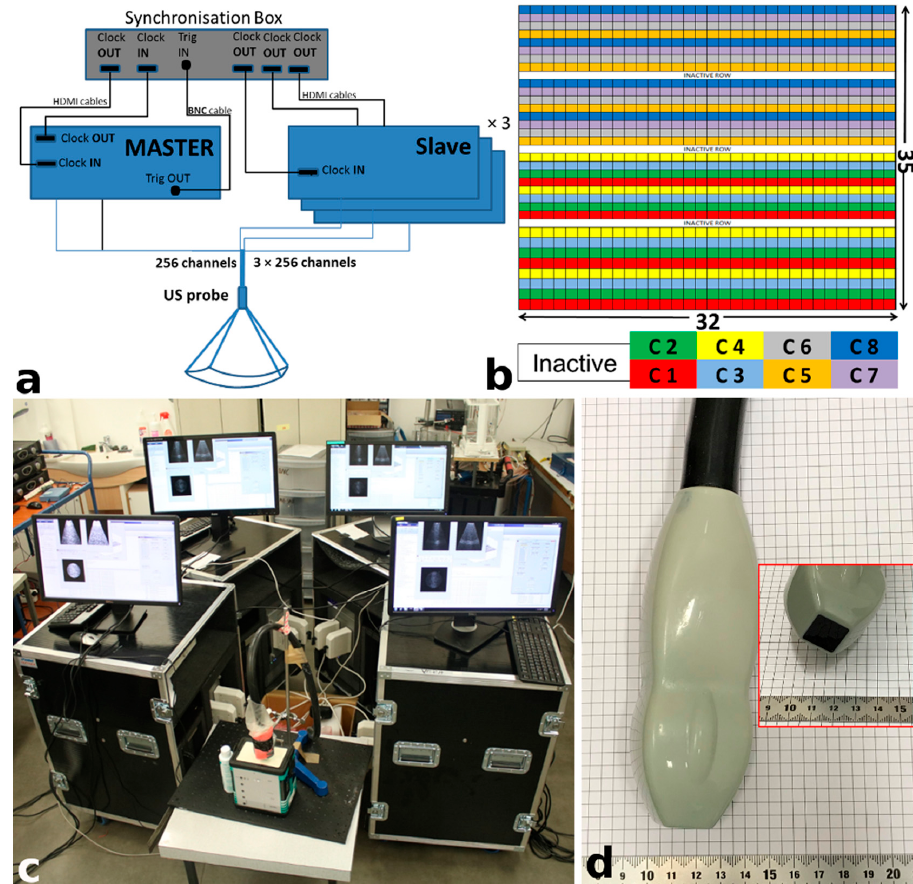
Figure 1. ( a ) Block diagram of the entre setup including the Master, the 3 Slaves, the synchronization box and the US probe; ( b ) Diagram of the 1024-element distribution across 8 connectors. Each color corresponds to a connector (C); ( c ) Picture of the 4 synchronized Vantage systems and the 3-D US probe connected; ( d ) the customized 3-D US cardiac probe.